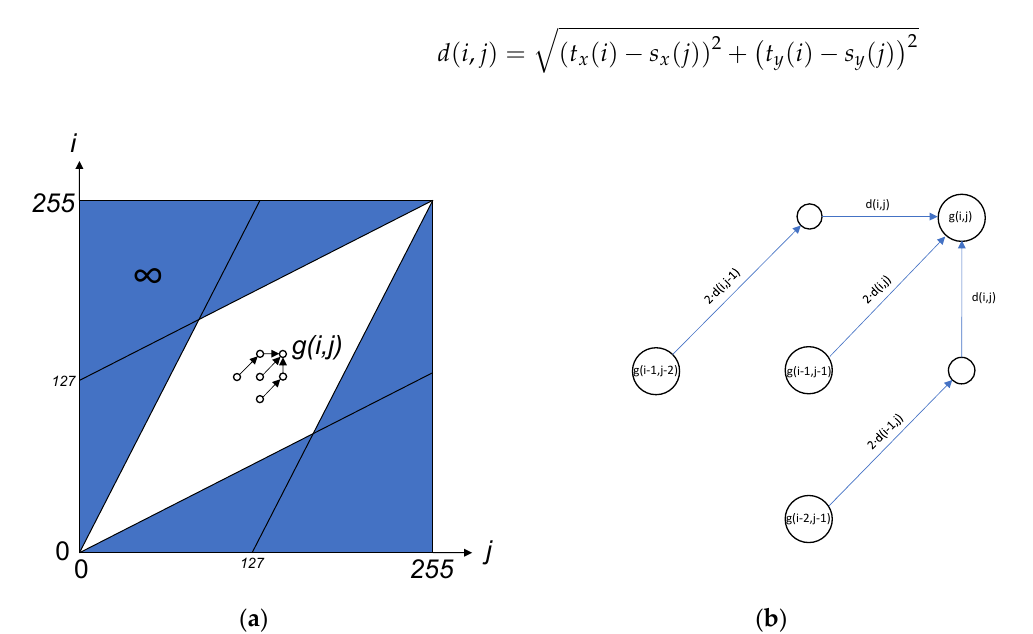
Figure 7. ( a ) The Itakura parallelogram DTW region R to compute the G matrix, and ( b ) the compu- tation of each g ( i , j ) element at the region